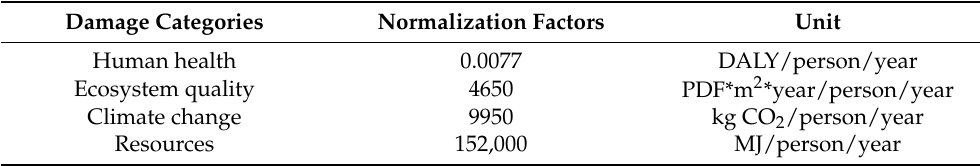
Table 6. Normalization factors for the four damage categories for Western Europe version 1.0